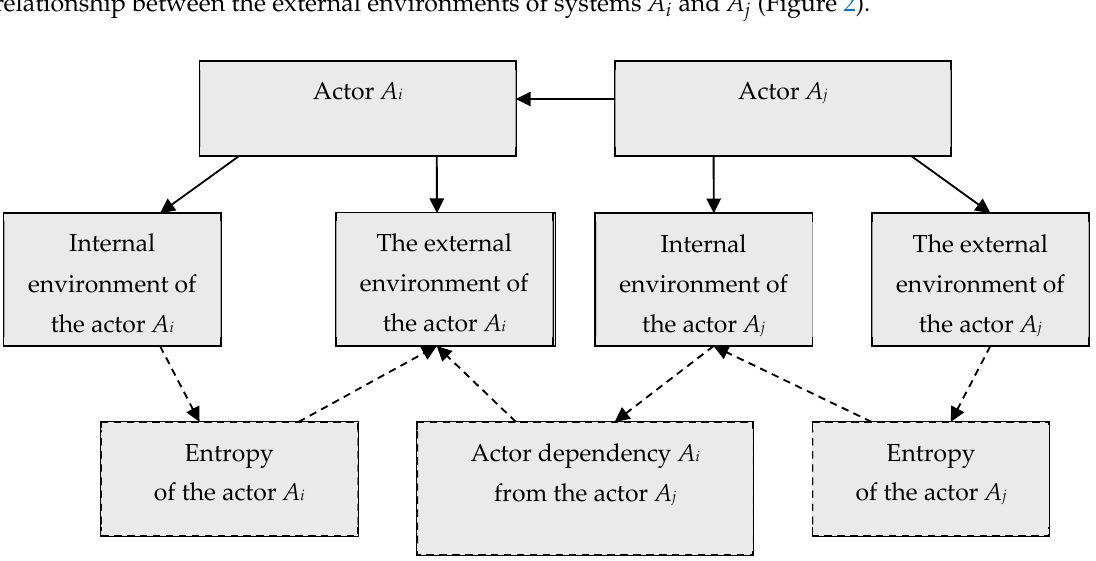
Figure 2. Interpretation of two systems behavior.